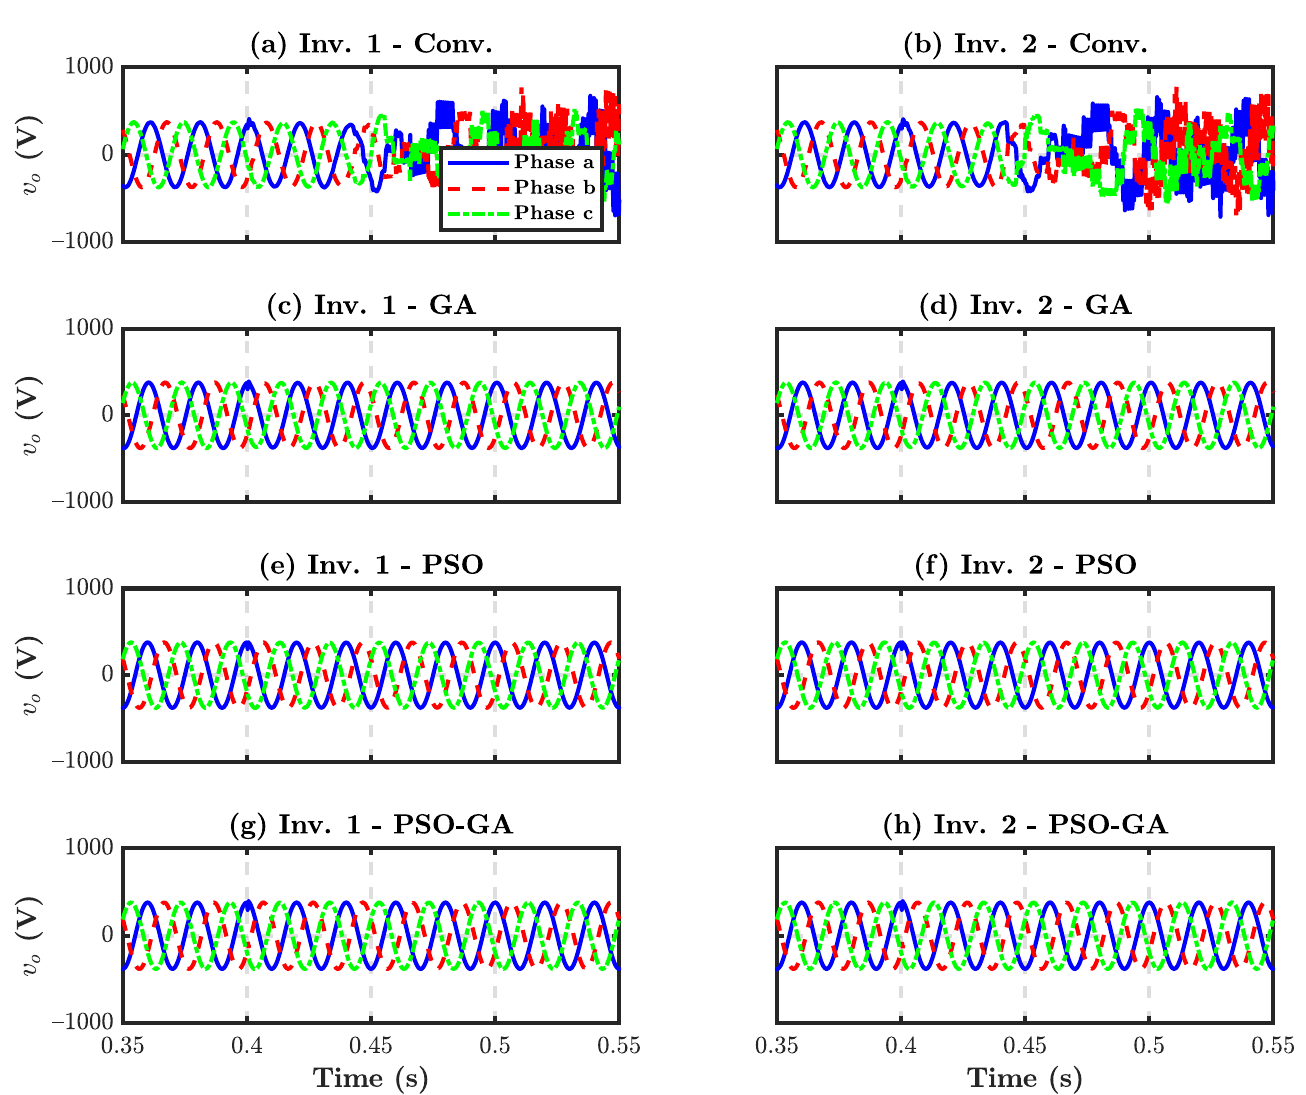
Figure 29. The inverters three-phase output voltages with different designed parameters in two- inverter MG: ( a ) inv. 1 with conv.; ( b ) inv. 2 with conv.; ( c ) inv. 1 with GA; ( d ) inv. 2 with GA; ( e ) inv. 1 with PSO; ( f ) inv. 2 with PSO; ( g ) inv. 1 with PSO-GA; ( h ) inv. 2 with